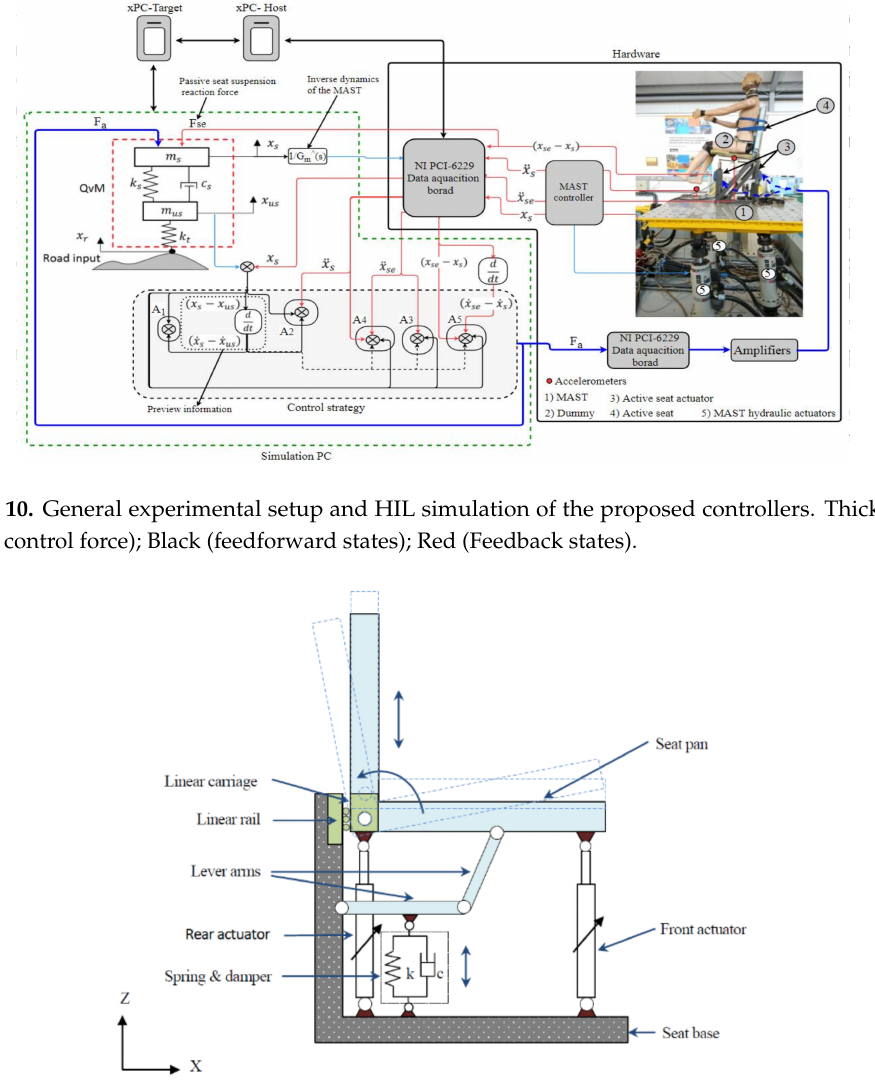
Figure 11. Schematic diagram of the active seat suspension. Reproduced with permission from [14], Elsevier,